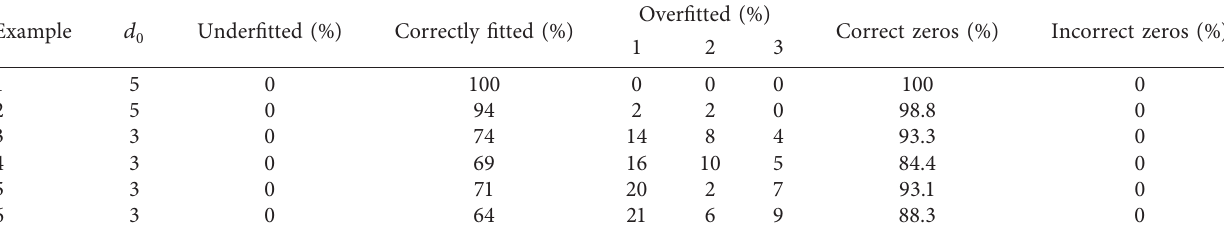
Table 2: Simulation summary of PHSpline for six examples.